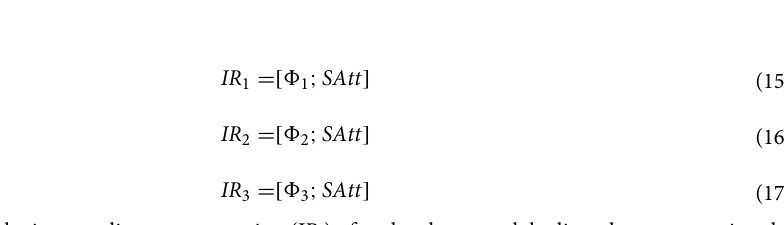
Table 5. Evaluation results of tenfold cross-validation. Values in bold are the maximum scores attained. MR: Mean Recall, s-F1: samples-F1. The baselines marked with * are the state-of-the-art methods and the results reported in the table are directly fetched from the cited work. Non-reported results for any particular metric is depicted as ’–’ in the